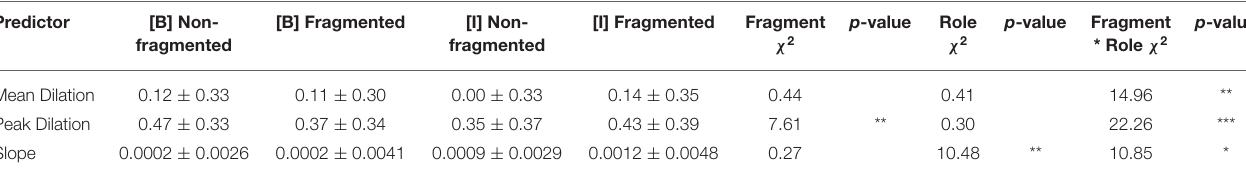
TABLE 3 | LMM on pupil diameter features of the Builder [B] and the Instructor [I], in Fragment (NoF-F) and Role (B-I) fixed factors. Predictor